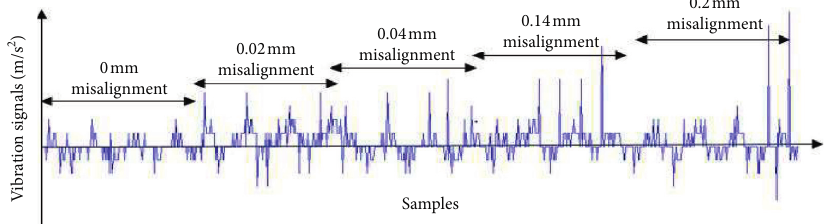
Figure 7: Vibration signals in vertical direction for parallel misalignment at 1200rpm.